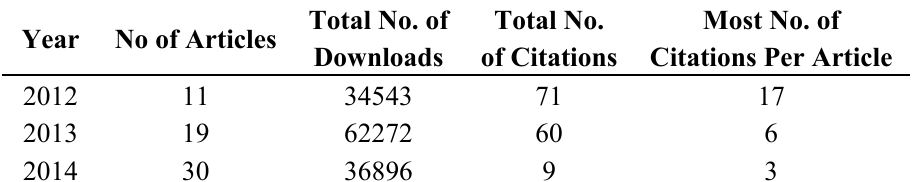
Table 2. Impact of APC